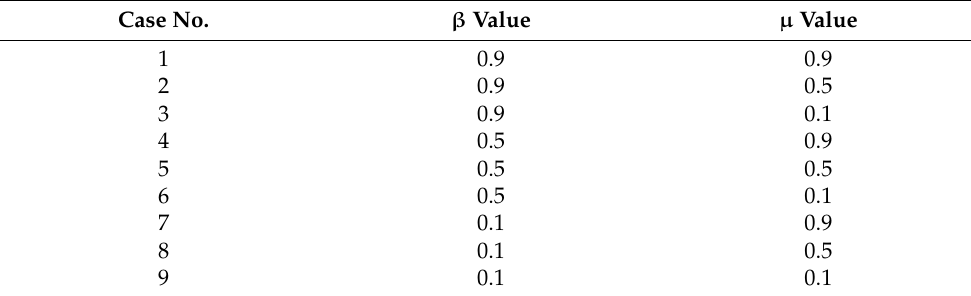
Table 1. Parameter-tuning cases for AO analysis. Case No. β Value µ